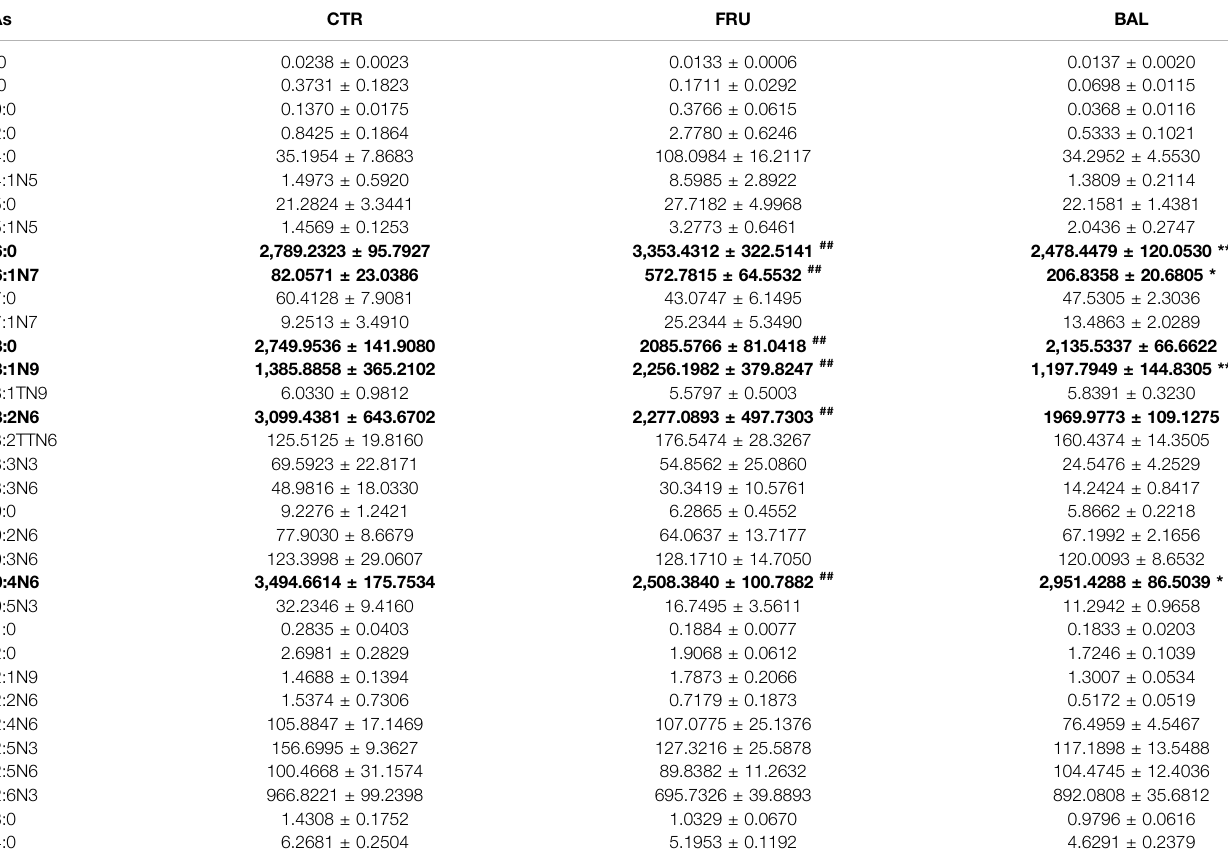
TABLE 3 | The content of FFAs in rat liver (mean ± sem, unit: μ g/g tissue). FFAs CTR FRU BAL